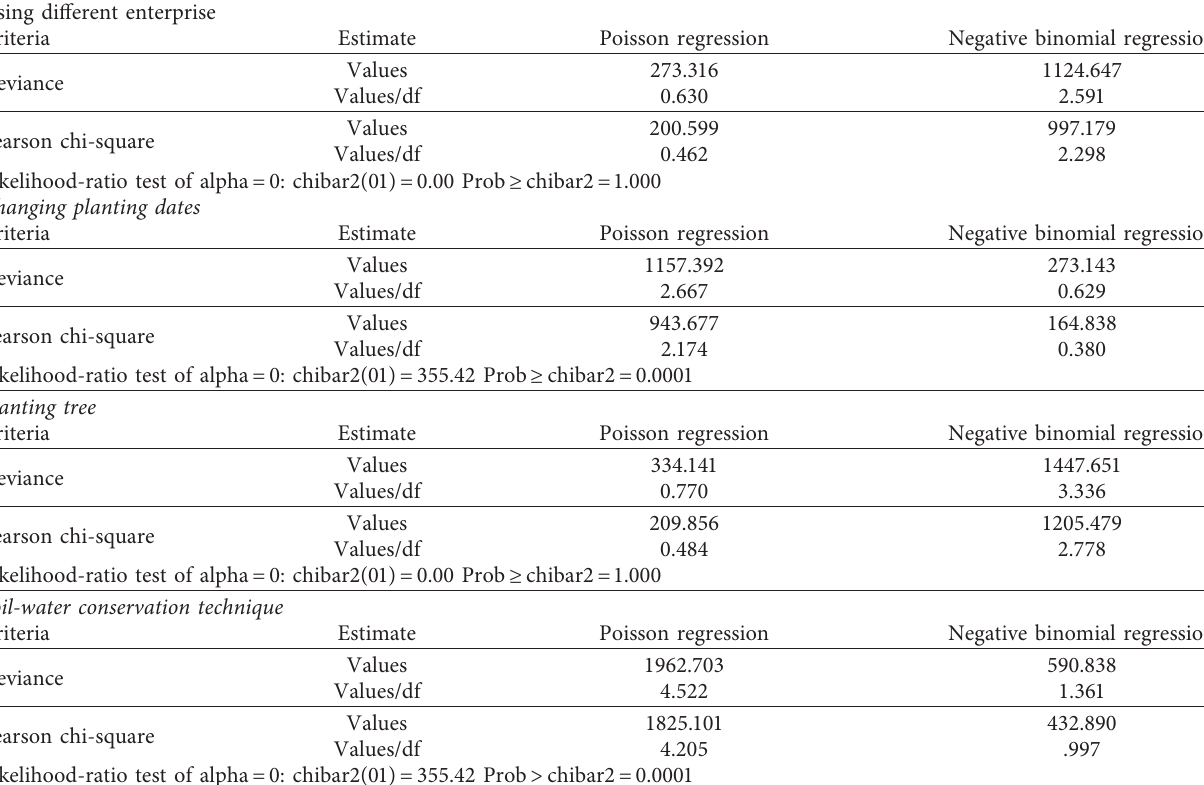
Table 3: Test for goodness of fit between Poisson and negative binomial regression